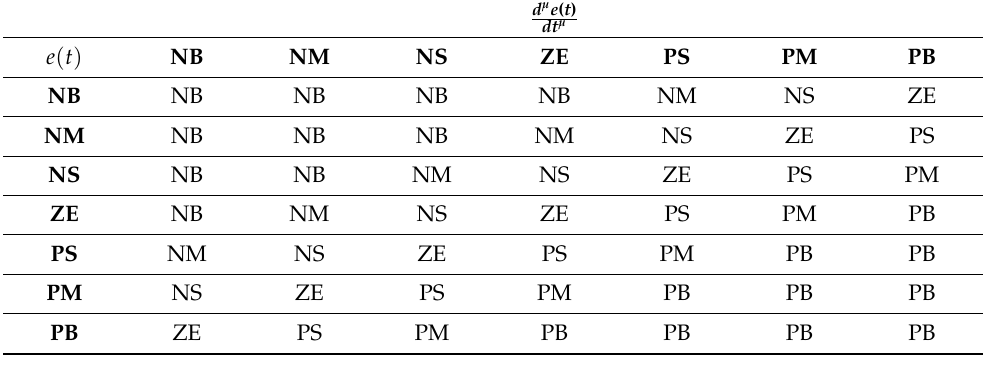
Figure 4. Surface view of fuzzy inference .